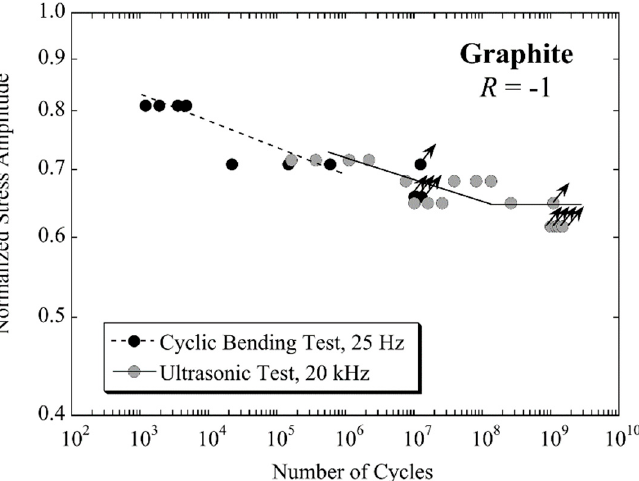
Figure 17. Fatigue data of polycrystalline graphite measured under fully reversed loading condition for cyclic bending (black circles) and ultrasonic tension–compression loading (grey circles), respectively; fatigue lifetimes are presented versus normalised stress amplitudes; adapted with permission from Elsevier [91].